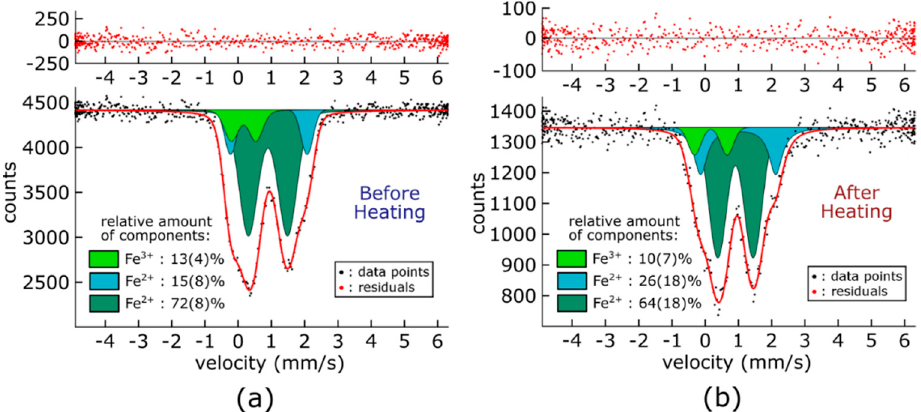
Figure 5. Fitted SMS spectra of ferropericlase crystal (C03 of Experiment 1), ( a ) before heating and ( b ) after being heated continuously at 30 GPa. The red solid lines show the theoretical fit of the data points (black dots) and the residuals are indicated above the spectra (red dots). Dark green and cyan doublets correspond to Fe 2 + components and light green doublet corresponds to the Fe 3 + component. The fitting parameters are presented in detail in Table 1. Minerals 2020 , 10 , x FOR PEER REVIEW